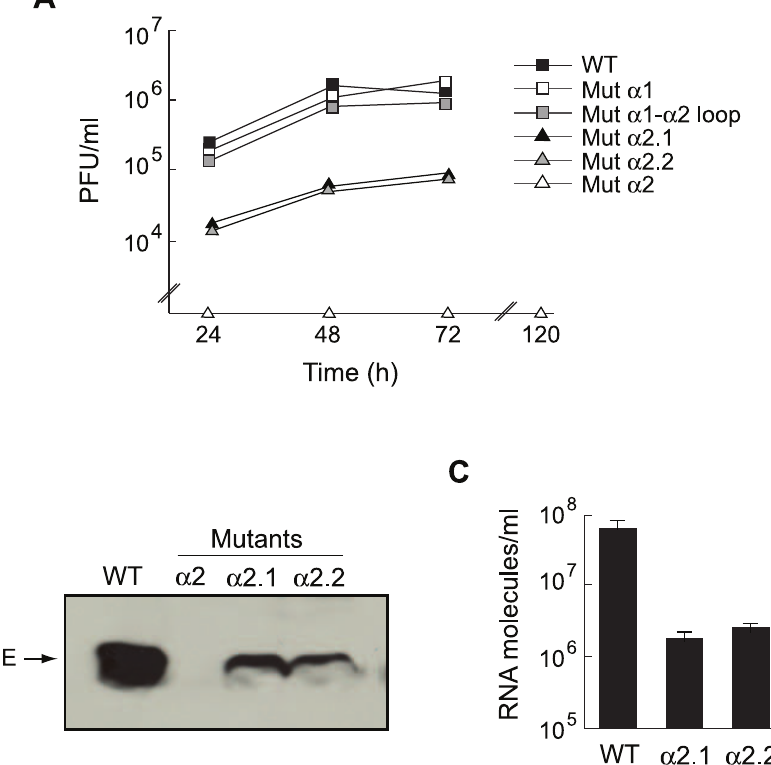
Figure 5. Targeting the C protein to LDs is necessary for DENV production. A. The media of BHK cells transfected with DENV RNA WT or mutants (Mut a 1, Mut a 1– a 2 loop, Mut a 2, Mut a 2.1, and Mut a 2.2) were collected as a function of time post-transfection and used to quantify the amount of infectious particles by plaque assay in BHK cells. The plot indicates the plaque forming units per ml at different times post-transfection. B. The secreted enveloped protein E was analyzed in the supernatant of transfected cells by western blot as previously described [33]. C. BHK cells were infected with a multiplicity of infection of 0.1 of WT, Mut a 2.1, and Mut a 2.2 viruses. The viral RNA was quantified by real time RT-PCR in the media obtained 24 h